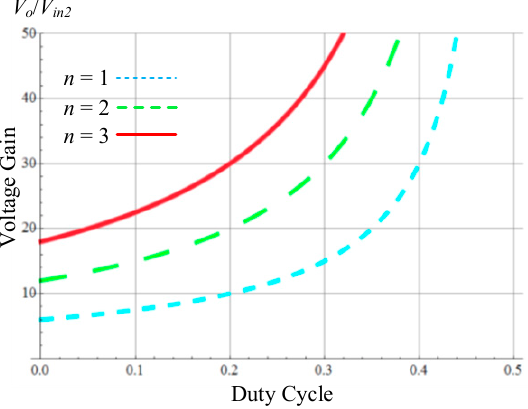
Figure 9. The voltage gain versus duty ratio under the DIO